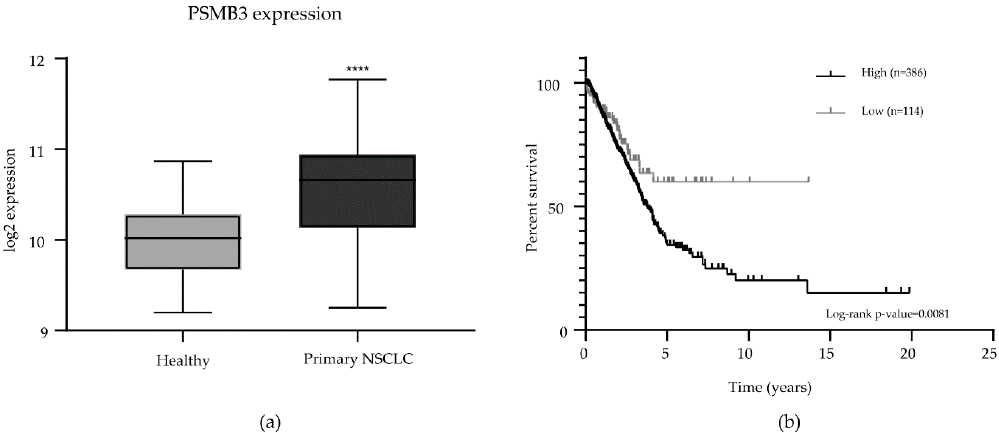
Figure 4. Analysis of publicly available data on PSMB3 expression in clinical materials. ( a ). PSMB3 is overexpressed in NSCLC ( n = 91) compared to adjacent normal lung tissue samples ( n = 65) in the NSCLC mixed non-small cell lung carcinoma dataset [14]. Error bars indicate the standard deviation. **** p < 0.0001. ( b ). Survival analysis of the Cancer Genome Atlas Lung Adenocarcinoma dataset [15] revealed that high PSMB3 expression corresponds to worse survival in patients with lung adenocarcinomas (log-rank p -value < 0.01; high expression n = 386; low expression n = 114).